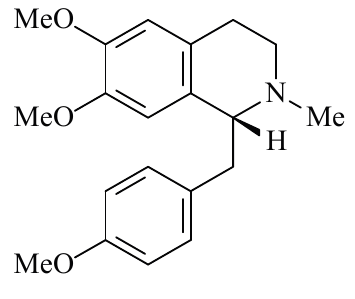
Figure 10. (+)- O -Methylarmepavine.